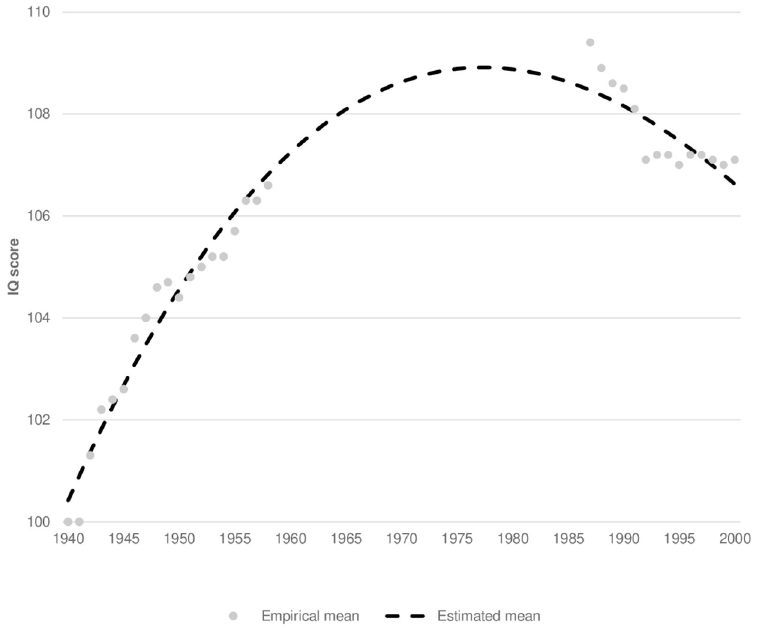
Fig 1. Mean intelligence test score according to annual birth